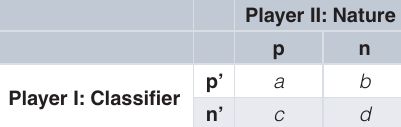
Table 2. Payoff matrix for a zero-sum game between nature and a binary classifier. a : Player I utility for a true positive. b : Player I utility for a false positive. c : Player I utility for a false negative. d : Player I utility for a true